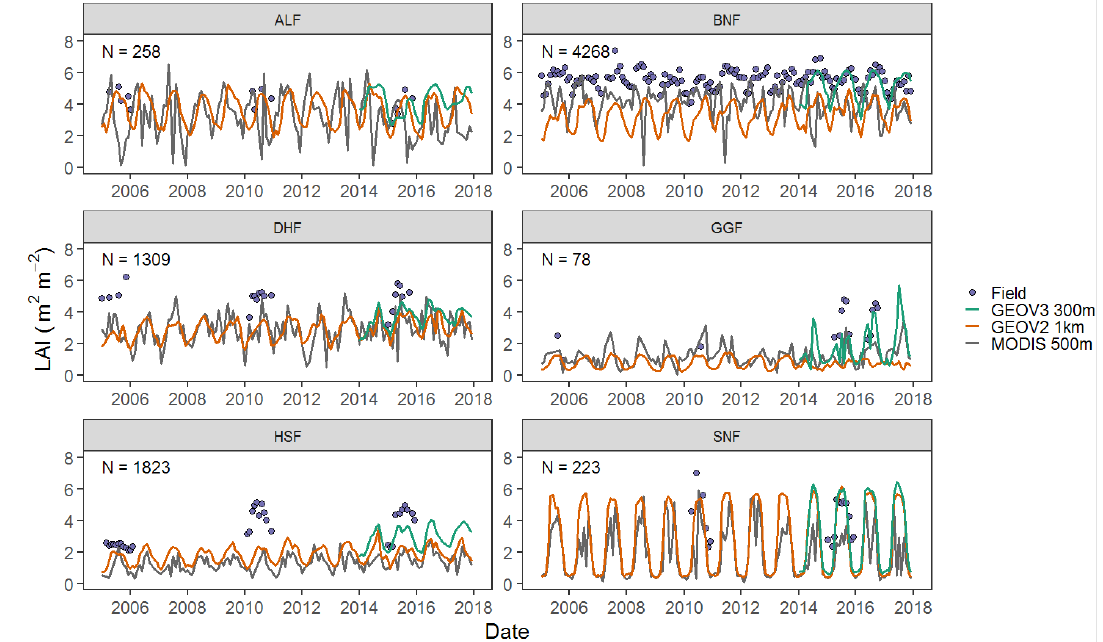
Figure 2. Time series of the LAI for the field, GEOV3 300 m, GEOV2 1 km, and the MODIS 500 m for different sites. The timespan of the LAI time series is from 2005 to 2017. Each field data point represented the mean value of the measurements from the sample subplots in each month. “N” denoted the number of total sample measurements for each site, including the repeat measurements in each month at each subplot.